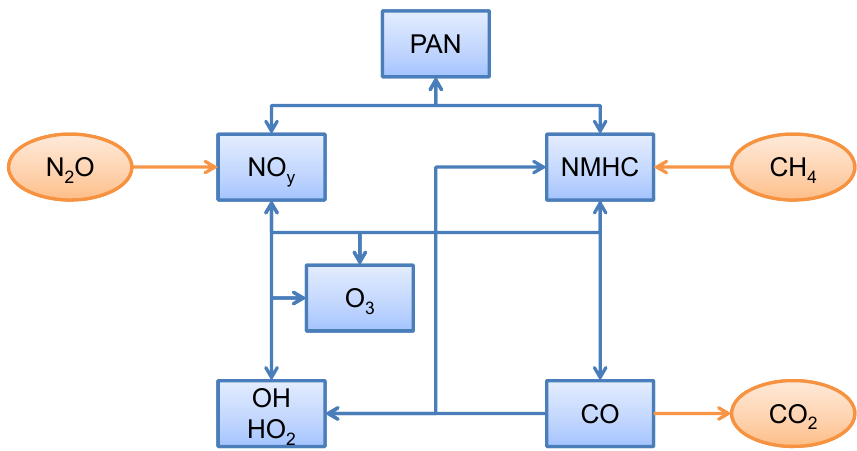
Figure 2. Sketch of the chemistry of tagged species (blue) and key relations to other species (orange). Note that stratospheric ozone is not included here. For HO x chemistry see also Fig.